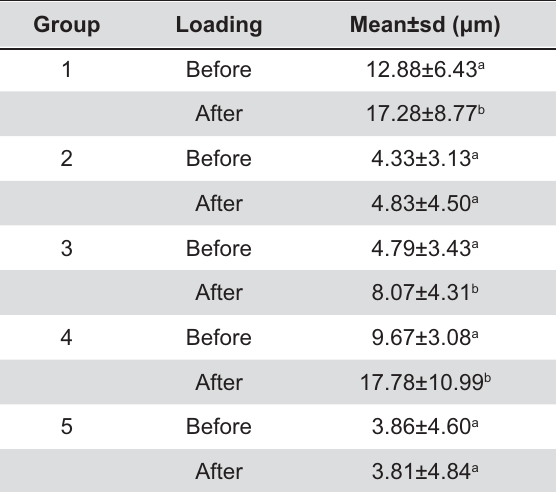
Groups with different letters are statistically different from each other; sd= standard